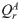
The spatial homophily and representation of the 23 mainland states of India at the Kumbh.The point estimates and 95% confidence intervals for QrA, the probability that any two given customers from state r are physically close to one another, (A) and QrD, the relative increase of state r’s spatial homophily on busy days compared to normal days, (B), both demonstrate an inverse relationship with state representation. The states have been ranked first by representation at the Kumbh (C) and then by degree of spatial homophily (D) (see S1 Text for the list of state names). The heat map colors correspond to the rankings. The yellow star is the city of Allahabad, the location of the 2013 Kumbh Mela. The near inversion of colors when comparing the two panels demonstrates a clear negative association between state representation and spatial homophily.